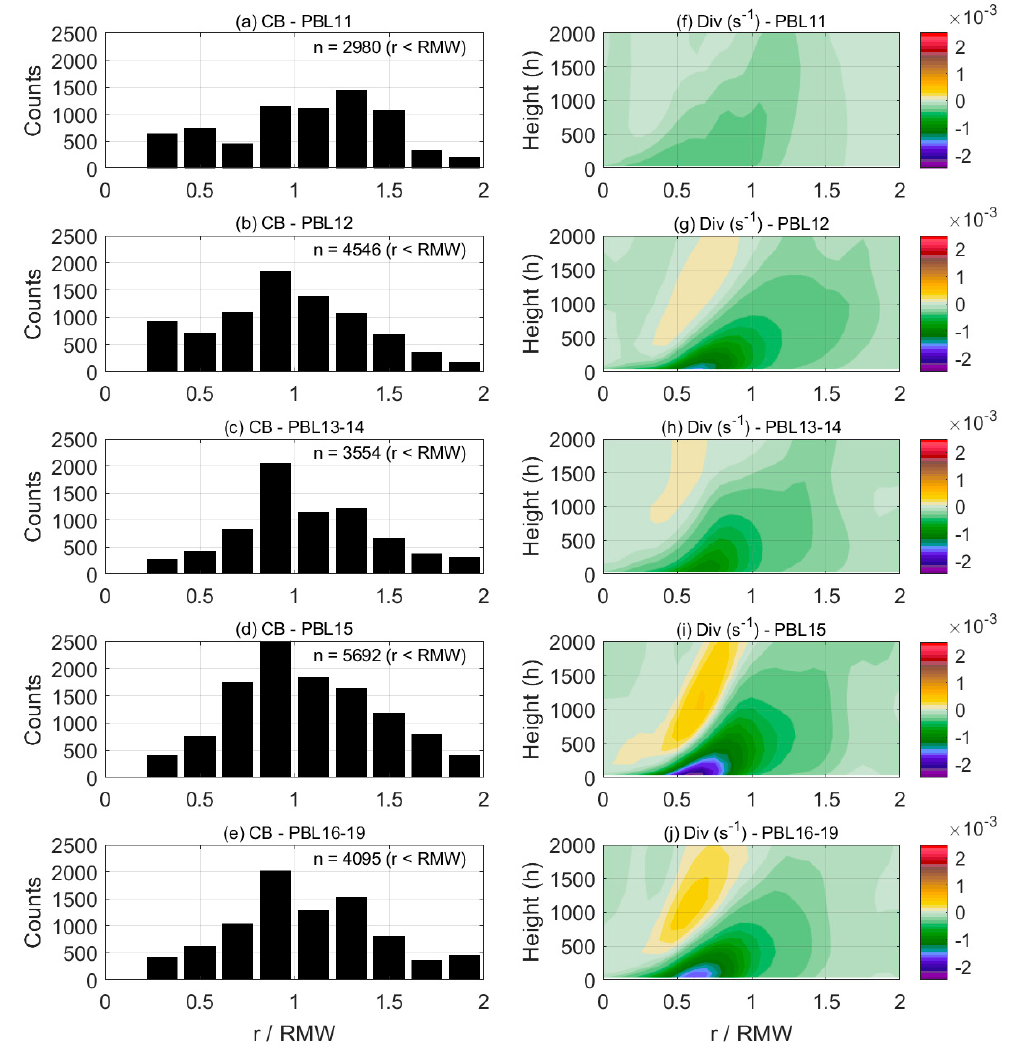
Figure 13. (Left) Plots of counts of convective bursts (CB) as a function of radius normalized by the radius of maximum wind speed (RMW). The total number of bursts (n) inside the RMW is also shown. (Right) Normalized radius-height plots of the azimuthally averaged divergence (Div) during the rapid intensification period (12–30 h). These results are from idealized HWRF simulations with ( a , f ) PBL11, ( b , g ) PBL12, ( c , h ) PBL13–14, ( d , i ) PBL15, and ( e , j ) PBL16–19 schemes.